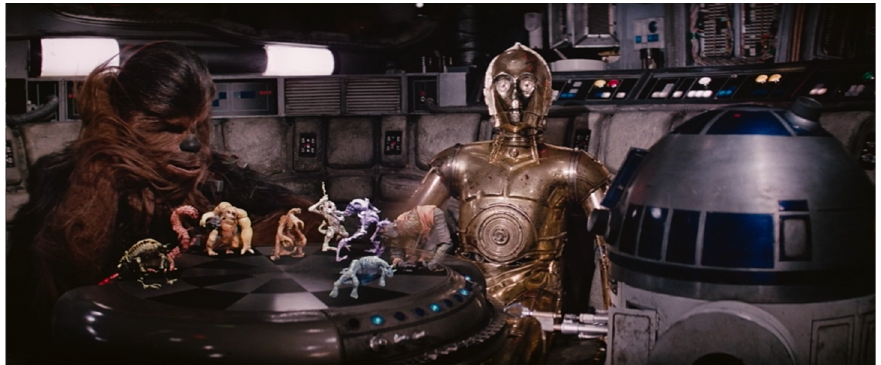
Figure 1. Chewbacca plays R2-D2 in a game of Dejarik (a.k.a. Holochess) while C-3PO observes in this scene from Star Wars: A New Hope (1977). (Screenshot created by author).